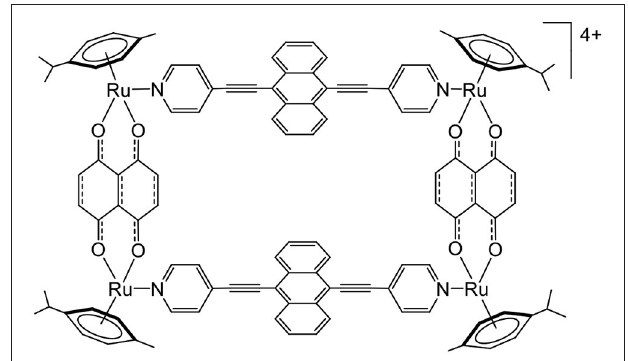
FIGURE 8 | Anthracene-based tetranuclear arene ruthenium metalla-assemblies for o 2 interactions (Gaschard et al.,